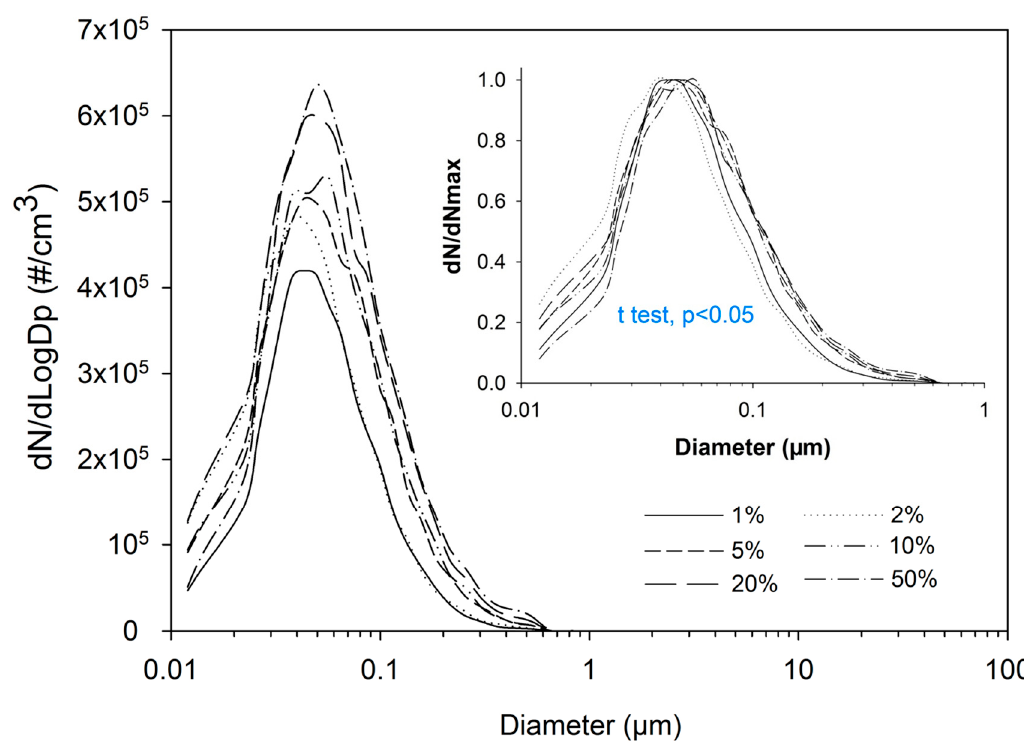
Figure 4. The influence of sucrose solution’s concentration on the normalized size distribution.